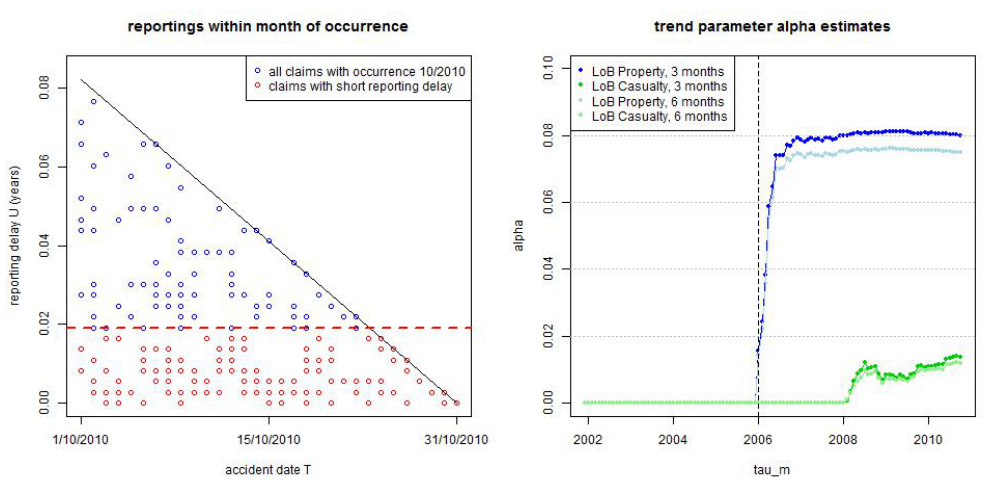
Figure 7. (lhs) small reporting delay layer as of 31/10/2010 for occurrence dates in 10/2010 of LoB Property, and (rhs) estimated trend parameter α at times τ m ∈ { 31/12/2001, . . . ,31/10/2010 } for LoB Property (blue/light blue) and LoB Casualty (green/light green) with dark colors are for u ( 2 ) = 3 months and light colors for u ( 2 ) = 6